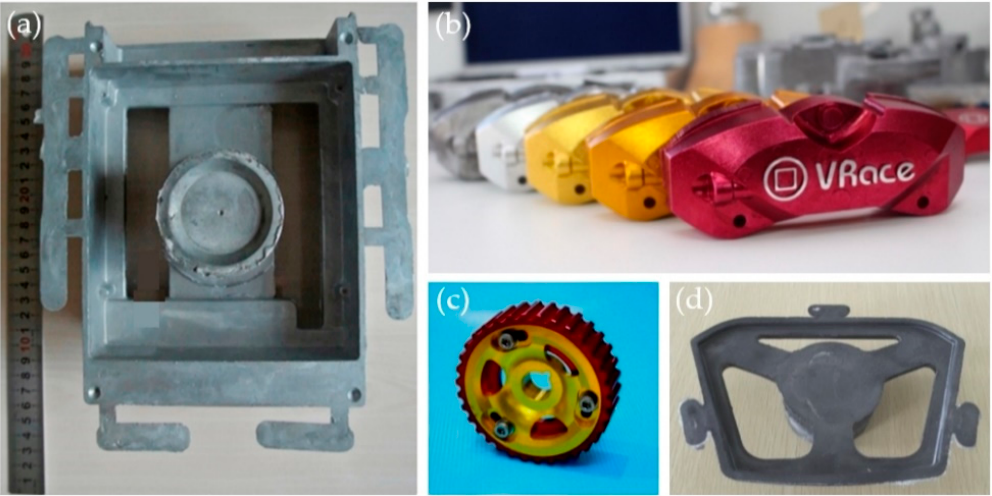
Figure 10. ( a ) 7075 Al shell part farbricated by the FCR [73], with permission from Elsevier, 2019. ( b ) Color anodized 7075 brake caliper parts and ( c ) gear fabricated by GISS [121]. ( d ) 2024 Al frame-shaped part fabricated by UV [95], with permission from Elsevier, 2019.